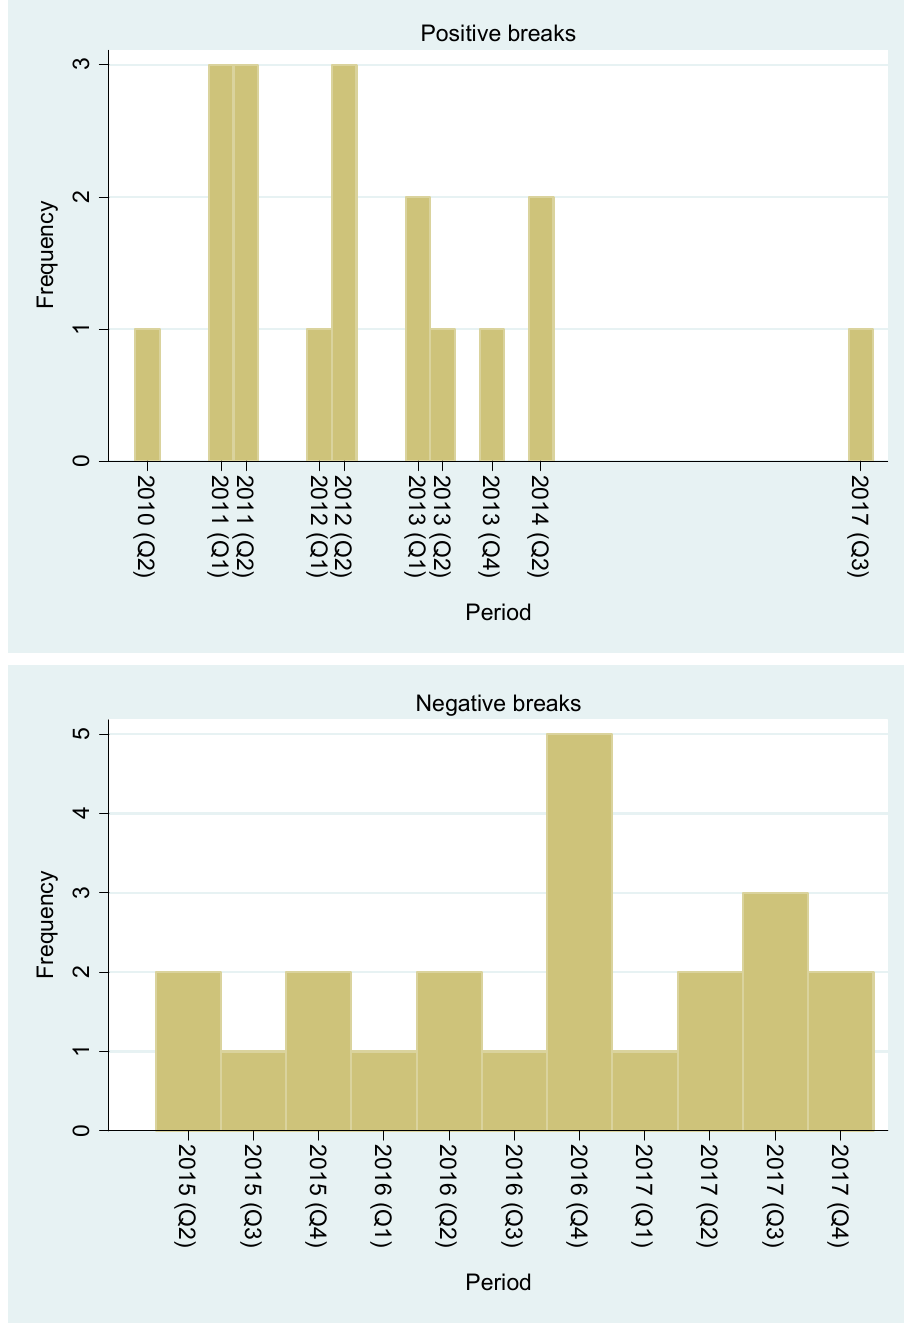
Figure 5. Temporal distribution of the second structural break. Distribution of the timing of the second structural break, two-break test of Clemente et al. (1998), AO model (Table 4). Only significant breaks are considered.